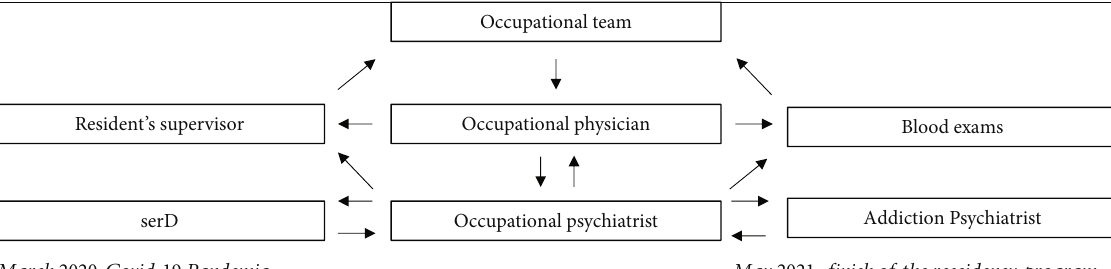
Figure 1: Intervention